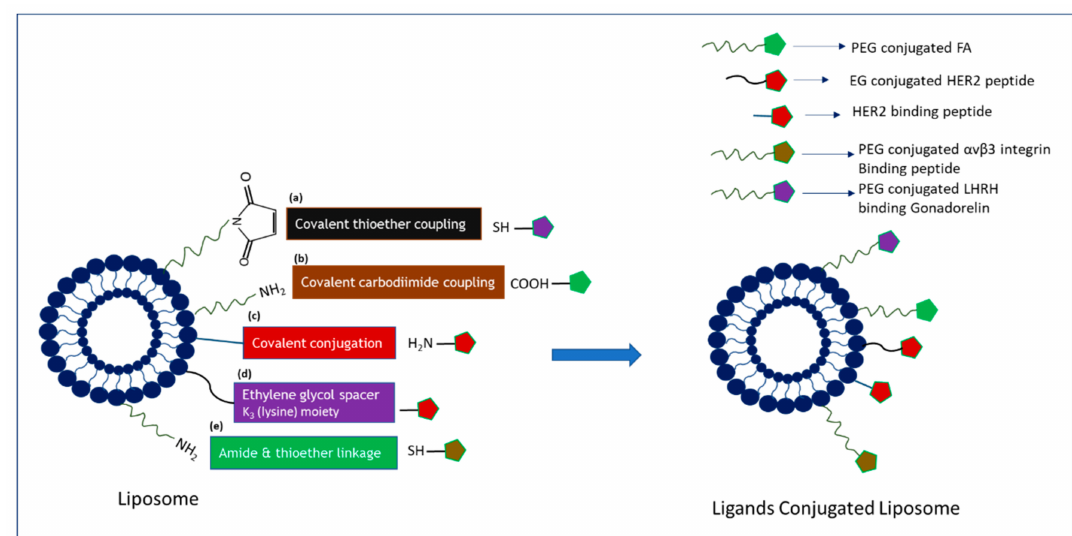
Figure 4. Strategies in adsorbing ligands onto the surface of liposomes: schematic representation of the reactions between the liposome bilayer containing functional groups and multiple ligands via (a) covalent thioether coupling, (b) covalent carbodiimide coupling, (c) covalent conjugation, (d) ethylene glycol spacer, and (e) amide and thioether linkage.